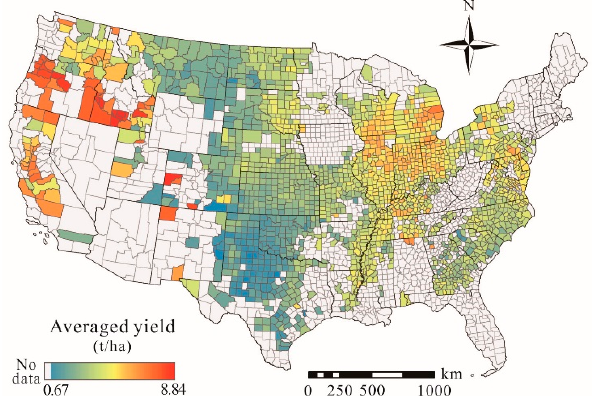
Figure 1. The county-level average yield over years 2008–2018 of the winter wheat in the CONUS.